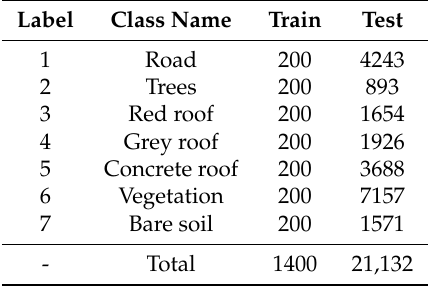
Table 4. The distribution of training and testing samples of the Grss_dfc_2014 data